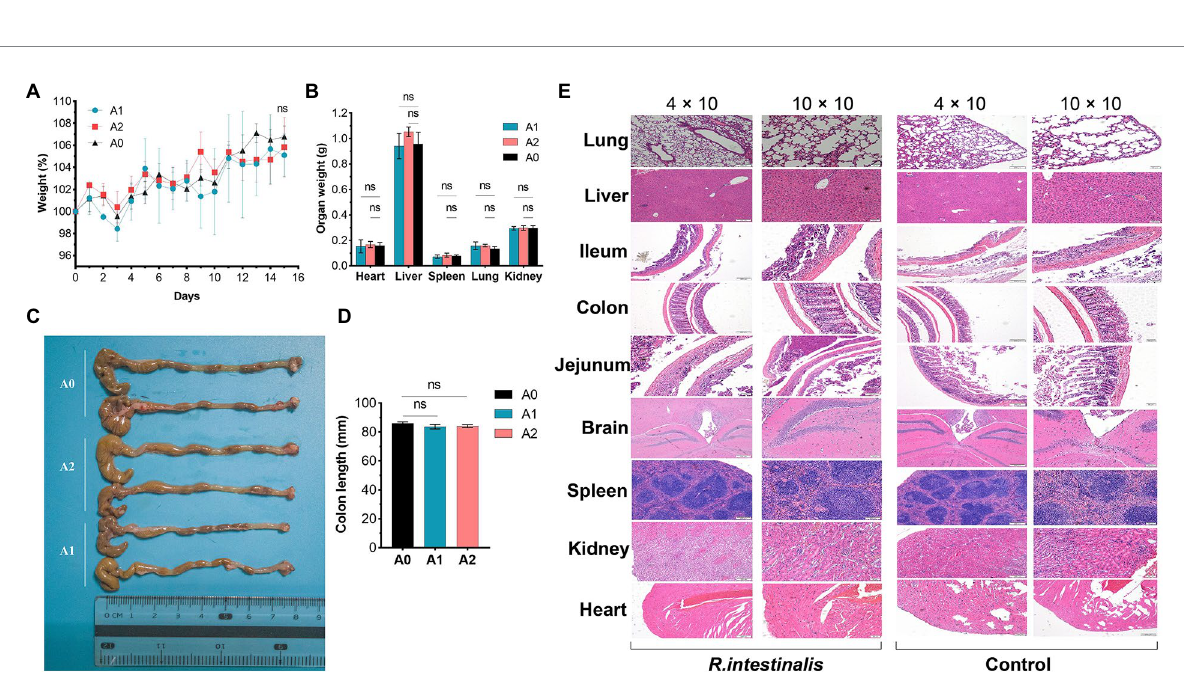
FIGURE 9 Acute toxicity study. (A) Body weight. (B) Weight of vital organs (heart, lung, liver, spleen, kidney). (C,D) Colon length. (E) Hematoxylin–eosin staining pathological examination results of vital organs. * indicates p < 0.05, ns indicates no